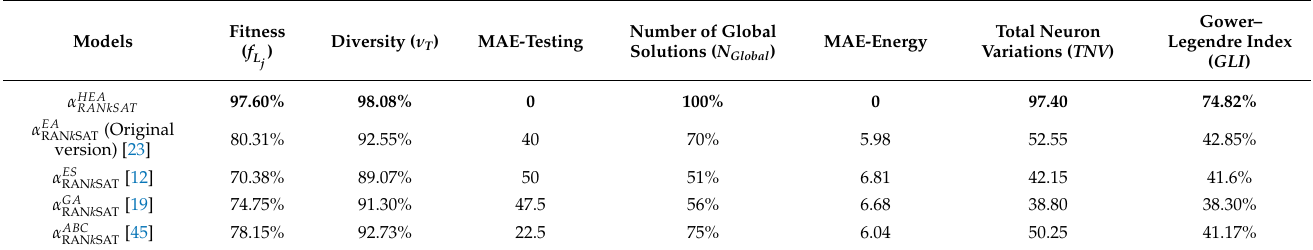
Table 12. Overall performance analysis for different DHNN-RAN k SAT models.